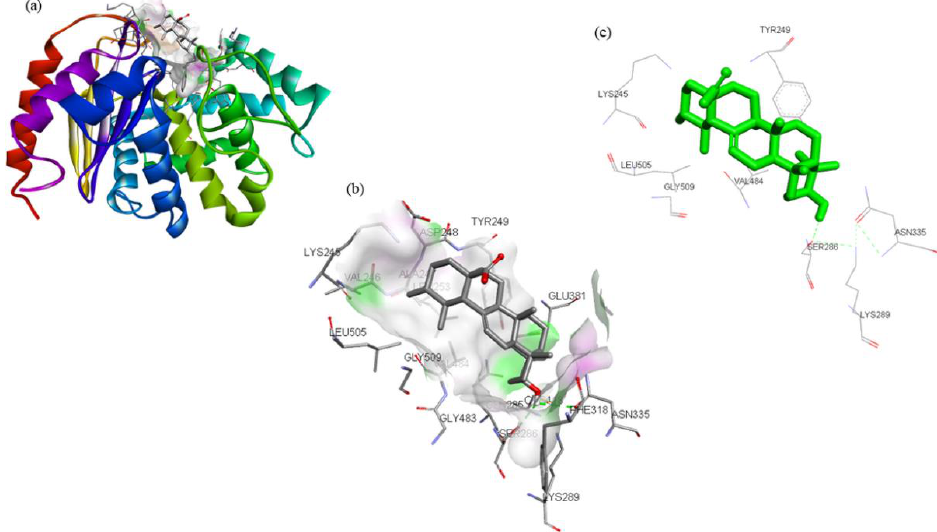
Figure 1. Visualization of ZINC03978829 (stick representation) in the binding pocket of GLS ( a ), interacting residues of GLS with ZINC03978829 ( b , c ). Table 3. BE and interacting residues of hits with GLS.